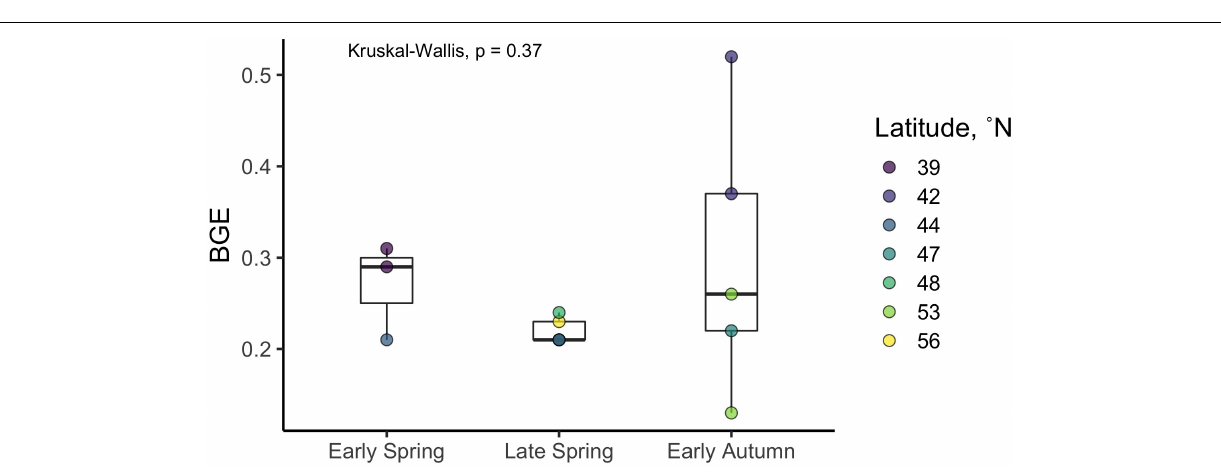
greatest in late spring and lowest in autumn/winter.